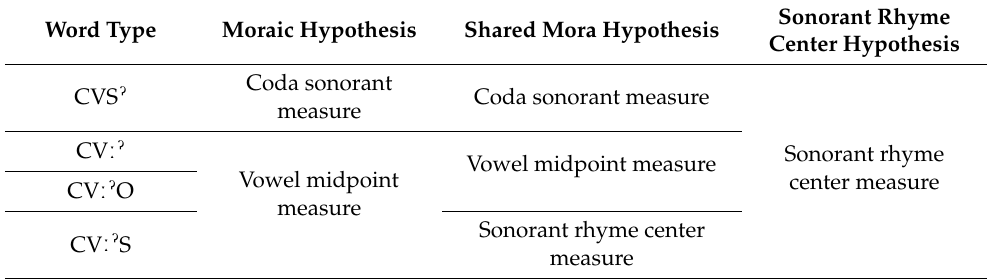
Table 8. Predictions made by the moraic hypothesis, shared mora hypothesis, and sonorant rhyme center hypothesis per word type. In each cell, the measure that is proposed to induce the least variability in stød onset timing, according to the stated hypothesis, is given for each word